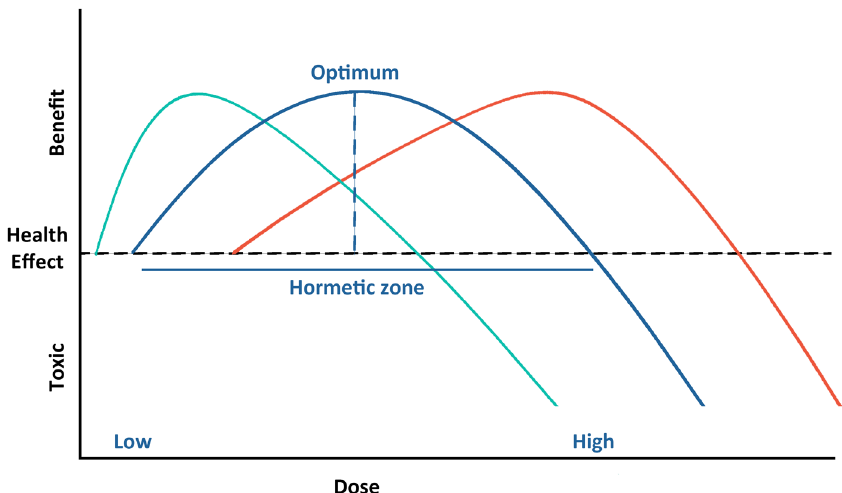
Figure 1. The biphasic-dose-response concept of cannabinoids’ effects on an individual. The blue line represents the theoretical dose-response curve between dose and health effects regarding benefits and toxicity. The vertical dash line indicates the optimum dose to provide health benefits. The range of health-beneficial doses is presented in the hermetic zone. The green and red lines represent the trends in sensitive and tolerant populations, respectively.